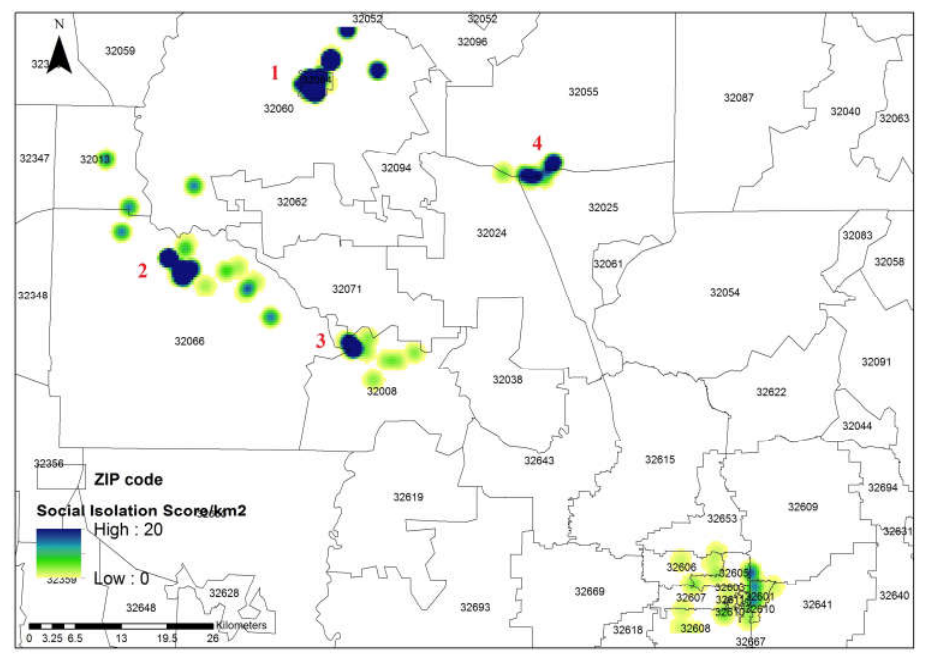
Figure 5. Kernel density map of visiting intensity of socially isolated participants. Dark colored areas indicate locations where participants with high social isolation scores were more likely to visit.